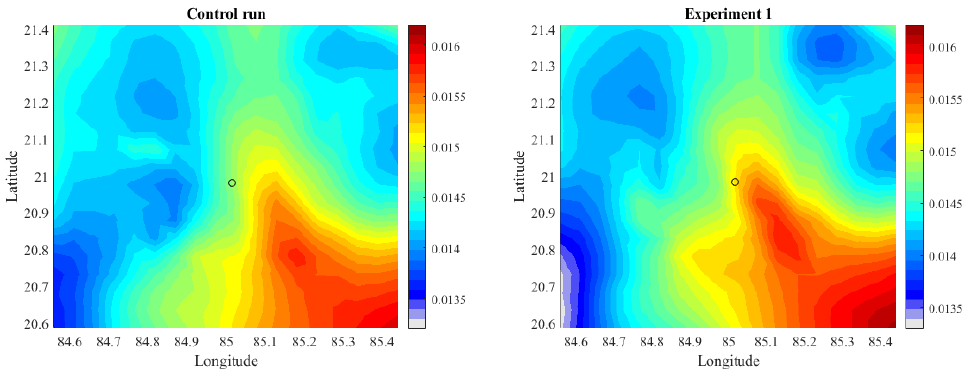
Figure 8. Water vapour mixing ratio comparisons on 22 March 2008 for WDM6 at near-surface level .